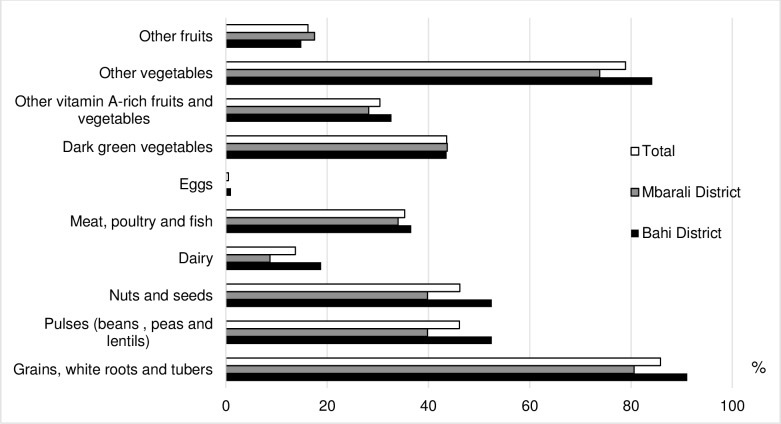
Percentage of women aged 15–35 years who consumed each food group in 2015.